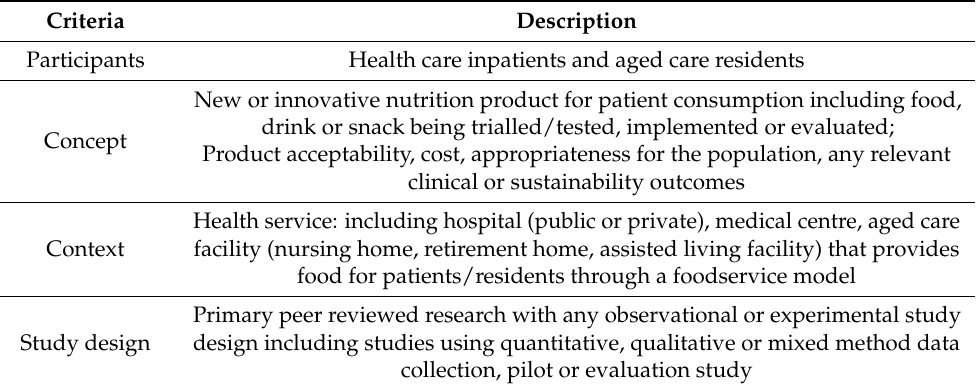
Table 1. Inclusion